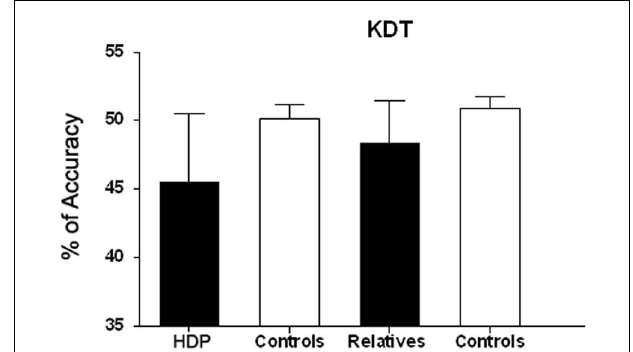
FIGURE 2 |Verbal processing (KDT) in HDP and RHD . KDT scale denotes percentage of correct responses (percentage accuracy) in HDP vs. controls. ** p < 0.0005; HDR vs. controls, p < 0.002; HDP vs. HDR, * p <